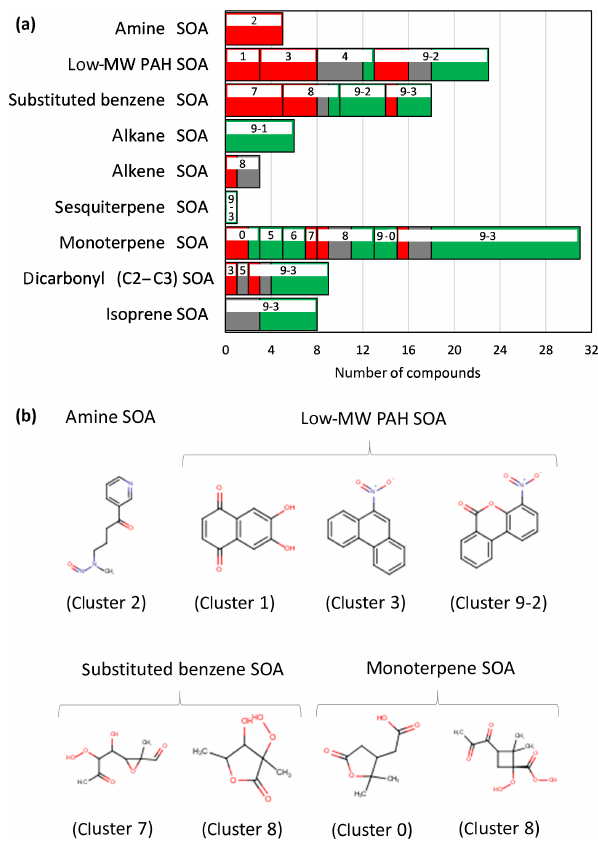
Figure 2. (a) Distribution of mutagenic (red), non-mutagenic (green) and indeterminate (grey) compounds between clusters (la- bels in white boxes) and SOA classes. (b) Examples of the molecu- lar structures of compounds predicted to be